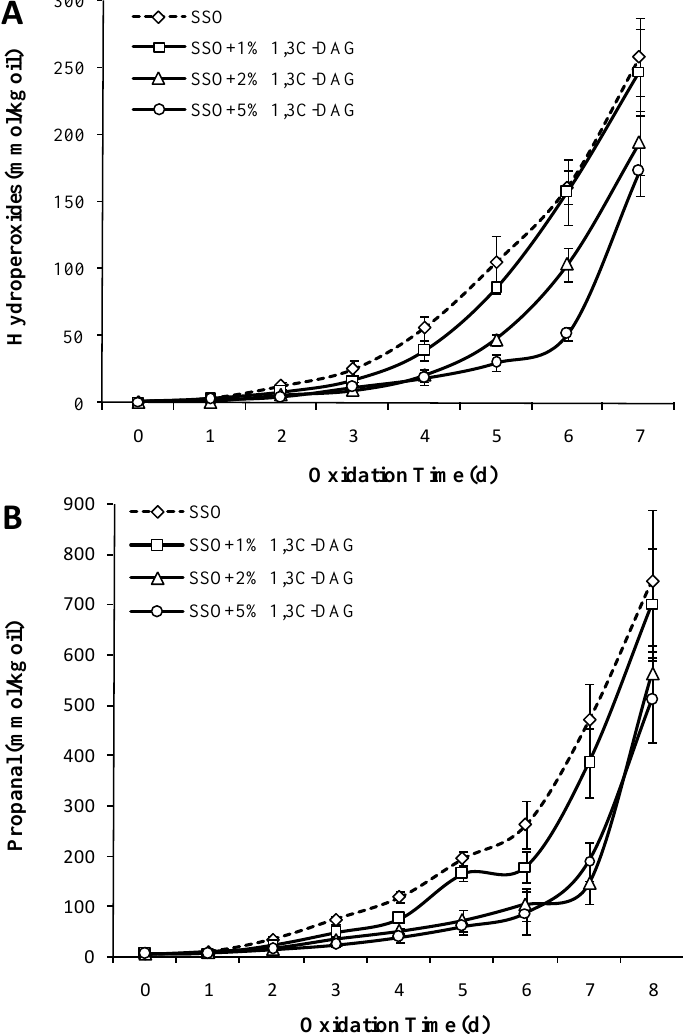
Figure 4. E ff ect of di ff erent concentrations of diacylglycerols with caprylic acid (1,3C-DAG) structured Figure 4. Effect of different concentrations of diacylglycerols with caprylic acid (1,3C-DAG) lipids on the content of POV ( A ) and propanal ( B ) in SSO (50 ◦ structured lipids on the content of POV ( A ) and propanal ( B ) in SSO (50 °C).